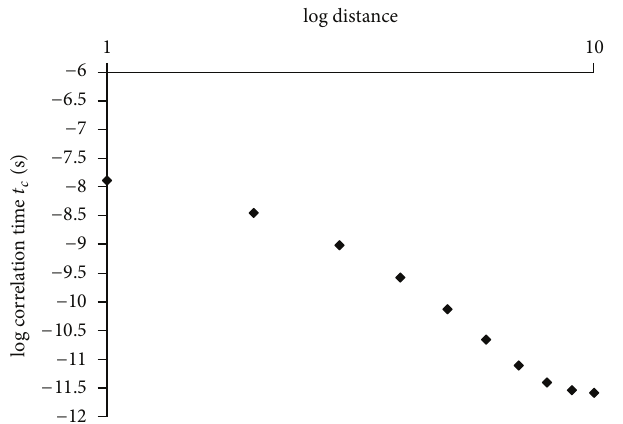
Figure 5: Computed values of the reorientational water correlation times typical of water molecules in the first tenth hydration shells around human albumin. Correlation time was calculated using equation (8) with 𝑎 = 2.5 × 10 −12 , 𝑏 = 4.8 × 10 −8 , and 𝑘 = 1.3 . The average correlation time over the ten shells was calculated using = ∑ 10 𝜒 𝜏 = 1.5 × 10 −9 s. the equation 𝜏 𝑐 𝑖 𝑐𝑖 𝑖=1 average